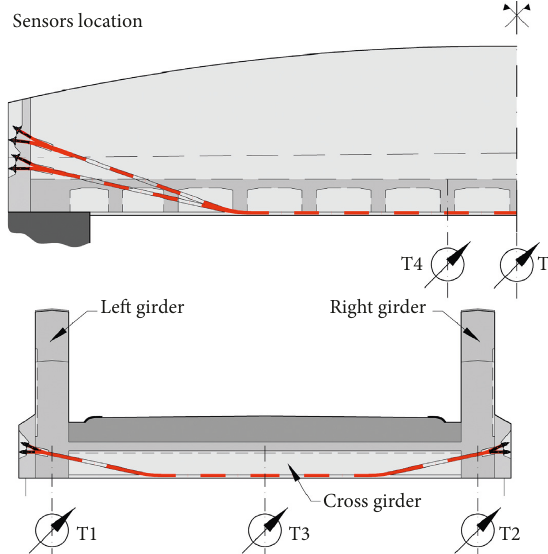
Figure 20: Location and description of deflection sensors in the longitudinal and transverse directions on the U-shaped bridge built in 1928 [23] for the purpose of a static load